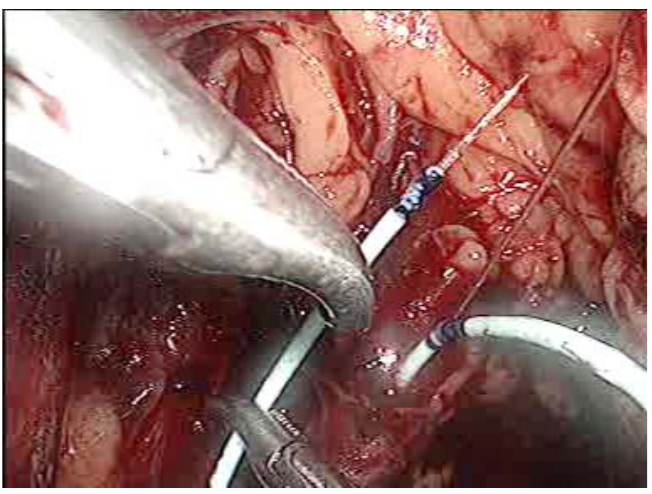
FIGURE 2 - A F 4.5 Double-J stent pre-inserted with plastic wire (guide wire of F 8 children chtreter) was inserted into the distal and proximal ends of ureter.